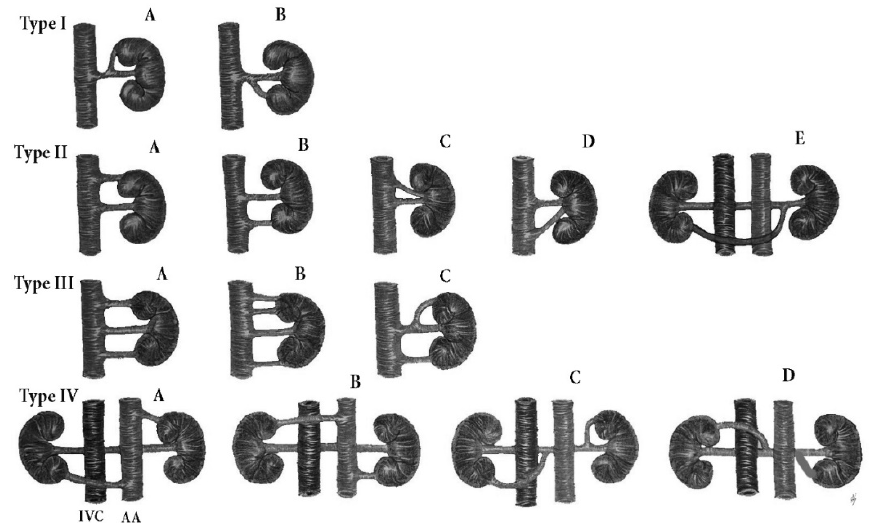
Figure 13. Additional renal arteries classification. Type I—additional renal arteries arising